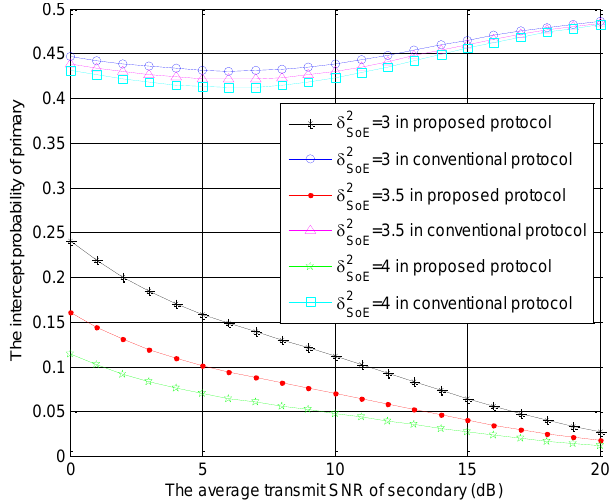
Figure 5. The intercept probabilities of primary users versus r 2 with different σ 2